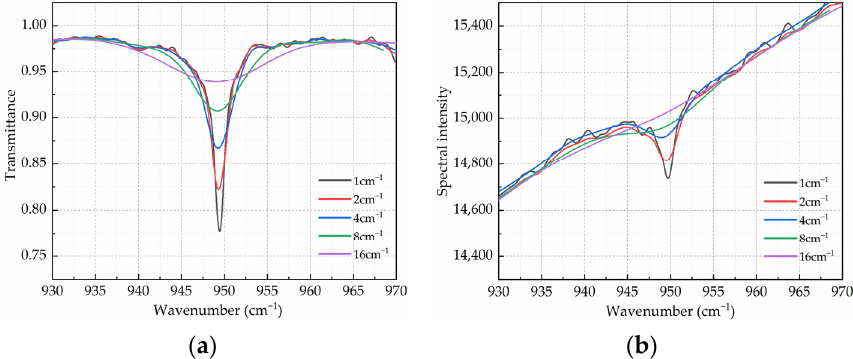
Figure 3. ( a ) The standard transmittance spectrum of C 2 H 4 with different resolutions; ( b ) the measured spectrum of C 2 H 4 with different resolutions.